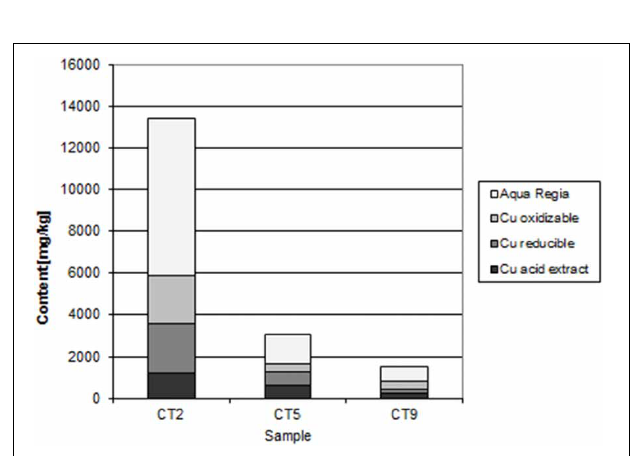
FIGURE 9 | Sequential extraction of Mindolo samples: